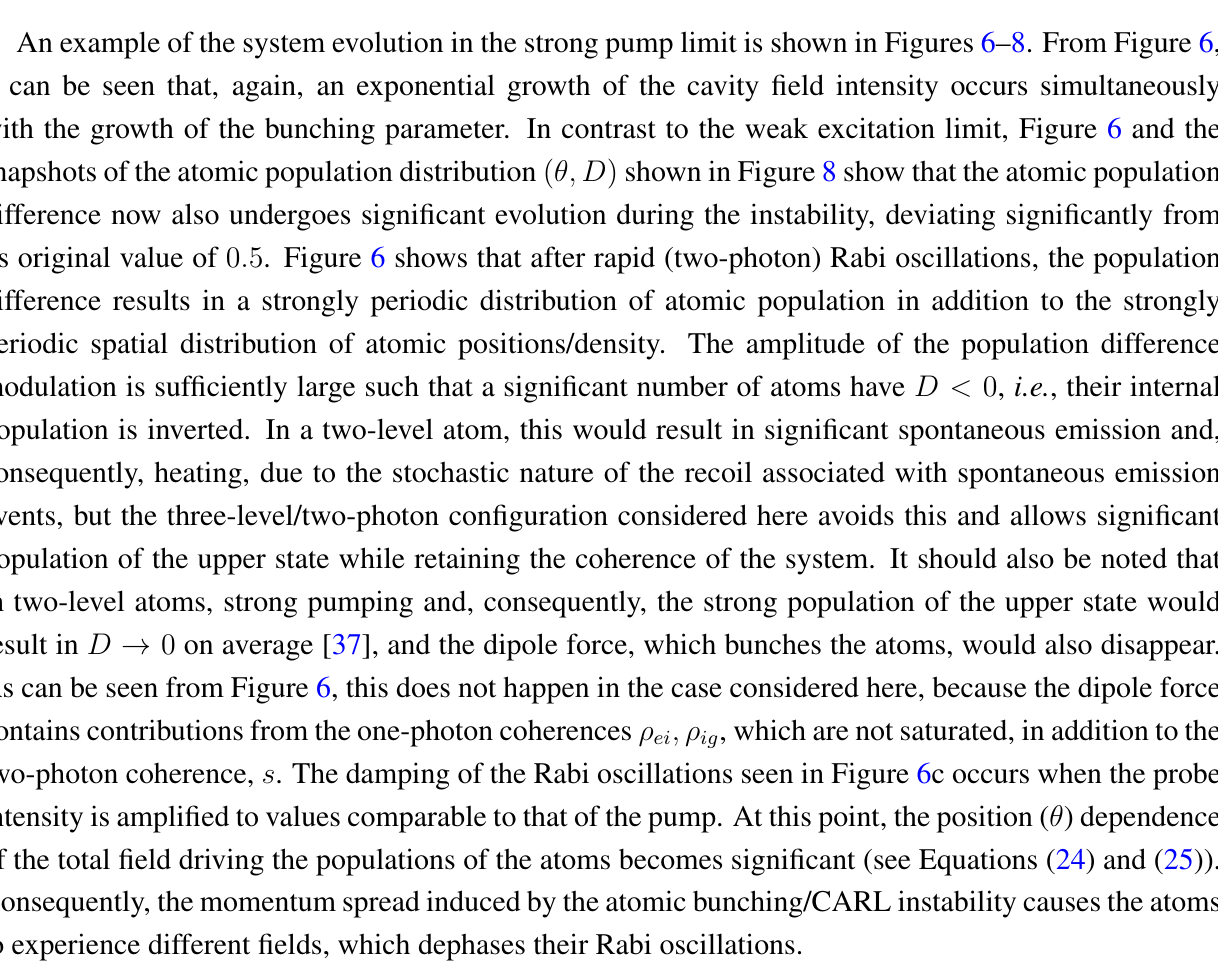
Figure 6. Evolution of probe photon number, | α population difference, < D > , for a case of strong excitation. The parameters used are U /ω = 5 × 10 − 5 , ∆ = 1 , α = 100 , N = 1000 0 r eg 2